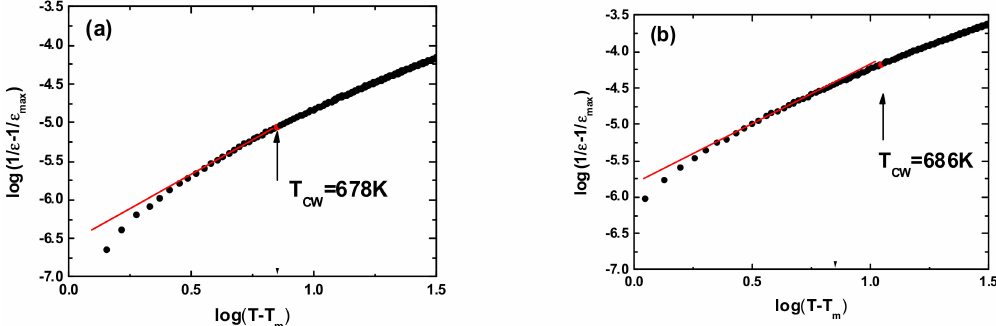
Figure 8. Log(1 / ε – 1 / ε max ) as function of log( T − T m ) at 10 kHz for KNN ceramics subjected to mechanosynthesis for a period of time equal to 75 h ( a ) and 100 h ( b ), symbols present experimental data; solid line—fitting to modified Curie–Weiss law.